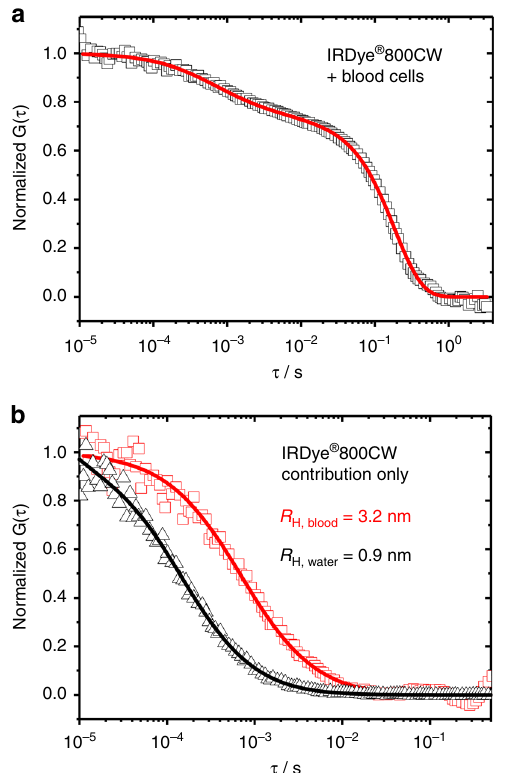
Fig. 3 NIR-FCS measurement of IRDye ® CW800-DBCO in fl owing blood. a Autocorrelation curve fi tted with Eq. (2) comprising contributions from fl uorescent dyes and blood cells. b Contribution from the blood cells was subtracted (Eq. (6)) from the autocorrelation curve of IRDye ® CW800- DBCO in blood (red). For comparison, the autocorrelation curve of IRDye ® CW800-DBCO in water (black) is also shown